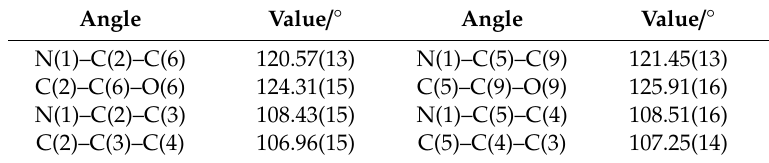
Table 2. Selected angles.